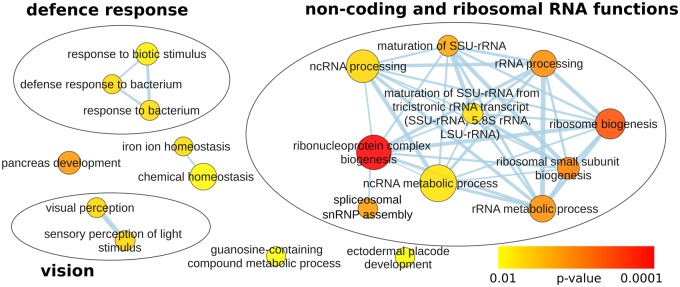
Enrichment of hybridization-derived variants in biological process GOs. Genes in the Oreochromis niloticus gene annotation were linked to zebrafish GO categories, and enrichment of Malawi variants differentially fixed between Victoria and Ruaha Blue (category 3 in table 1) relative to private Malawi variants (category 1 in table 1) in exonic regions was tested (Materials and Methods). Categories with enrichment P-values <0.01 are shown. Size of the circles is proportional to the number of genes present in the annotation in each category (from 10 to 220). Analogous analyses with different normalizations are given in supplementary figures S16 and S17, Supplementary Material online.